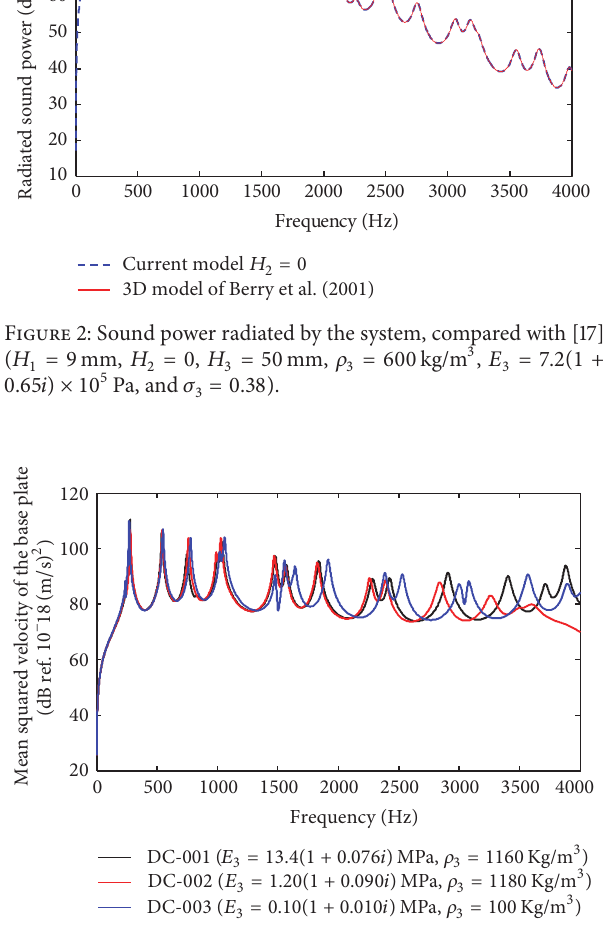
Figure 3: Mean squared velocity of the base plate ( V 2 1 ) for the three specimens.